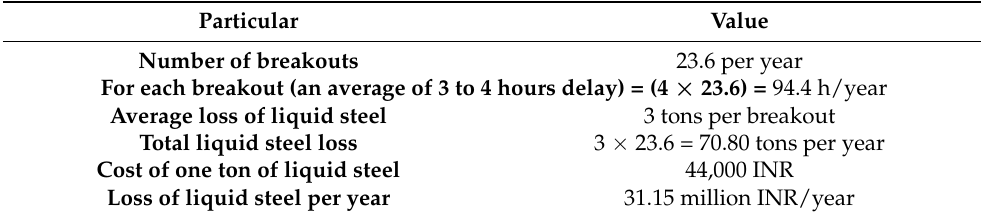
Figure 1. Pareto Analysis of reasons for breakouts at BSPL. Table 1. Revenue loss due to